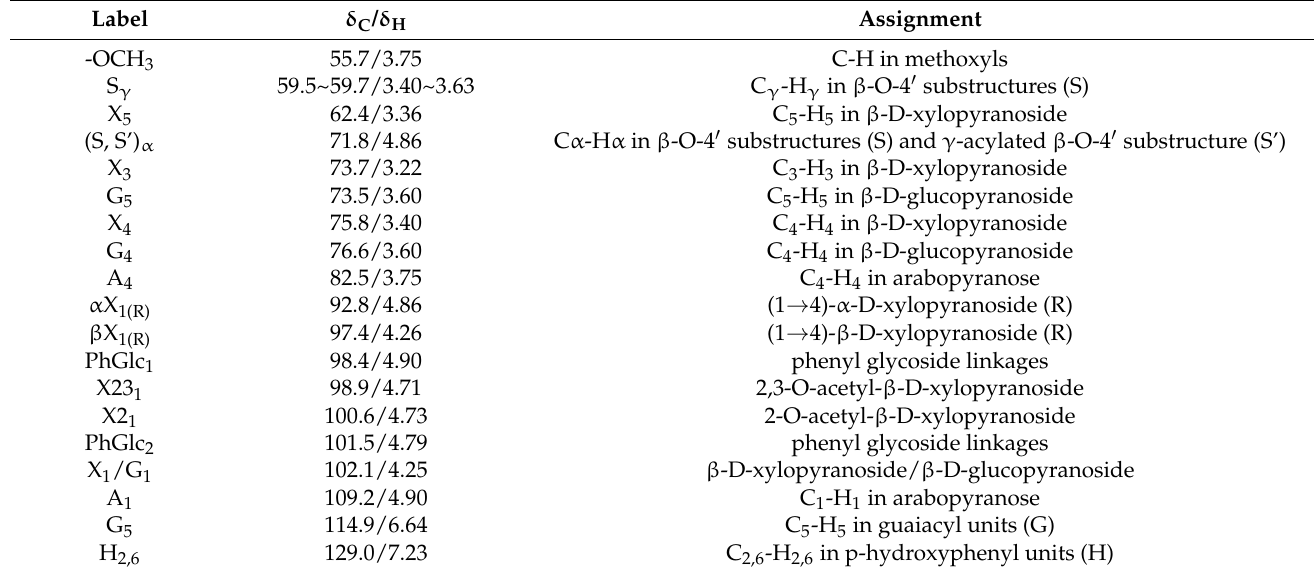
Table 4. Annotation of 2D 1 H- 13 C HSQC-NMR spectra